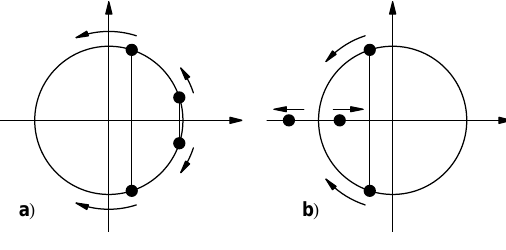
L Figure 4. Transition of two characteristic multipliers into the real